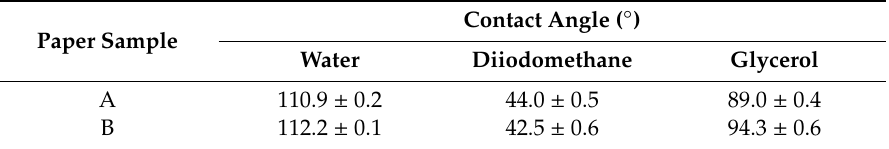
Table 4. Contact angle ( θ ) measurements with test liquids on paper